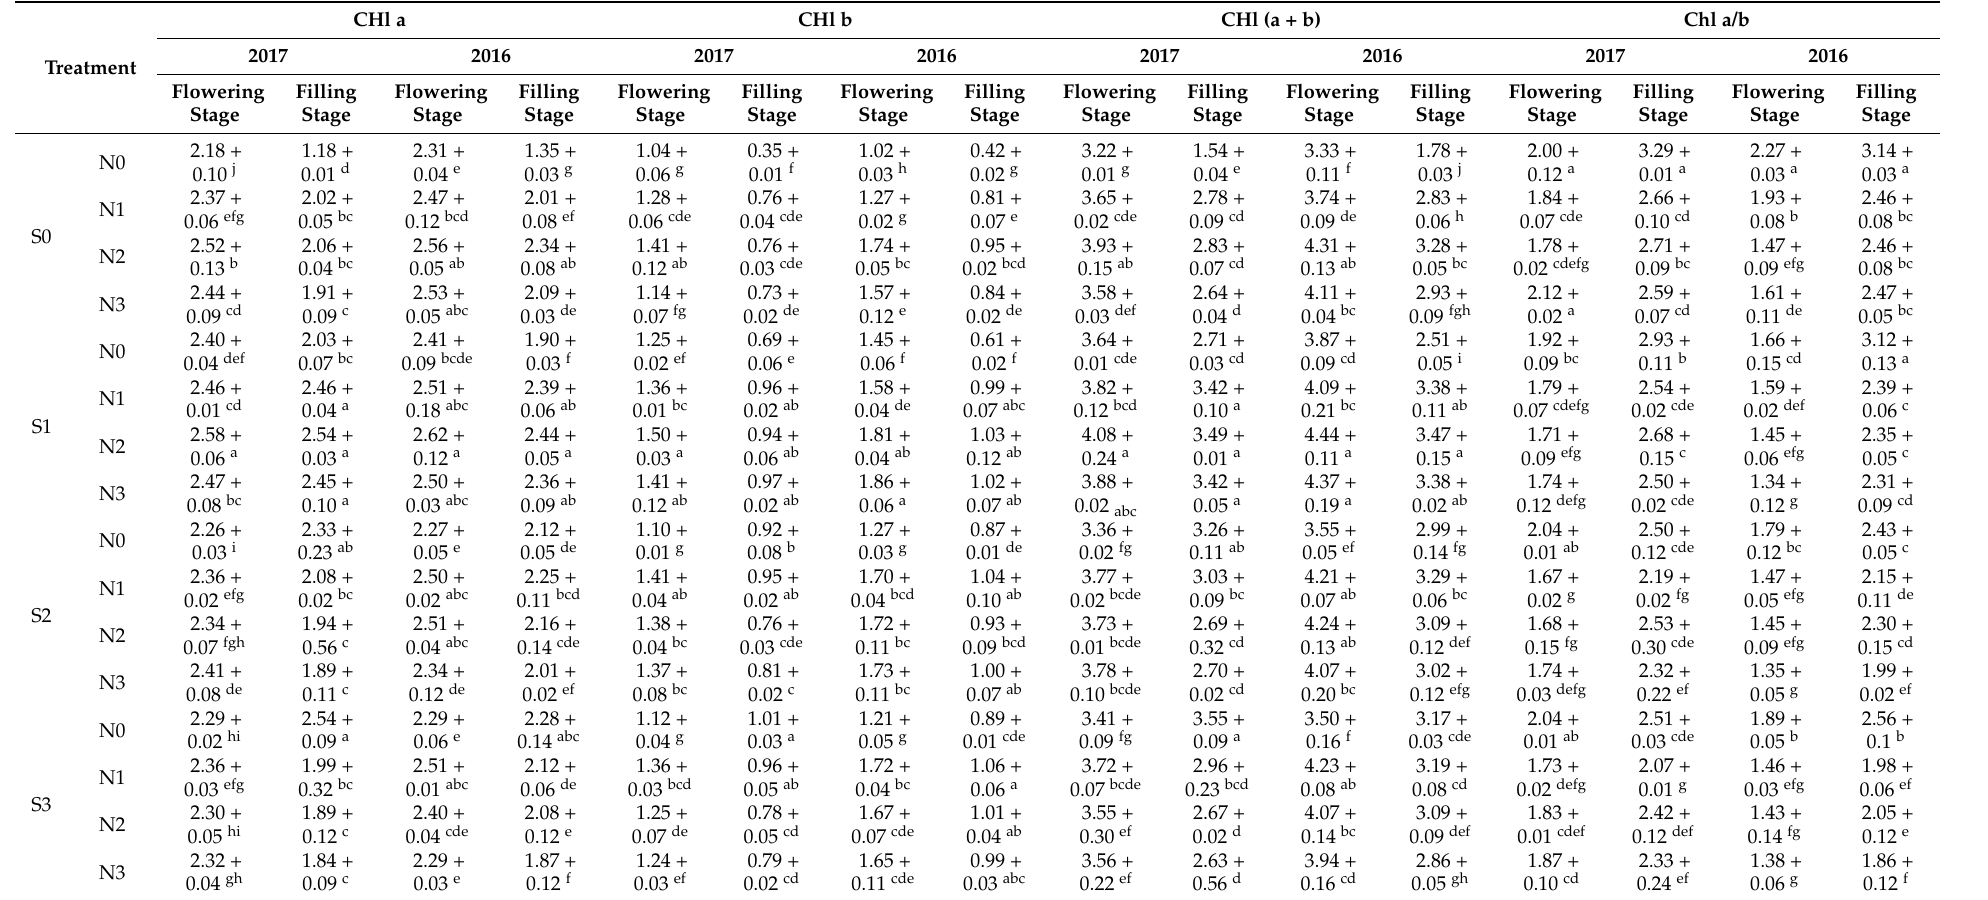
Table 2. Effect of light and nitrogen treatment on the chlorophyll Chl a, Chl b, Chl (a + b), and the Chl a/b ratio of